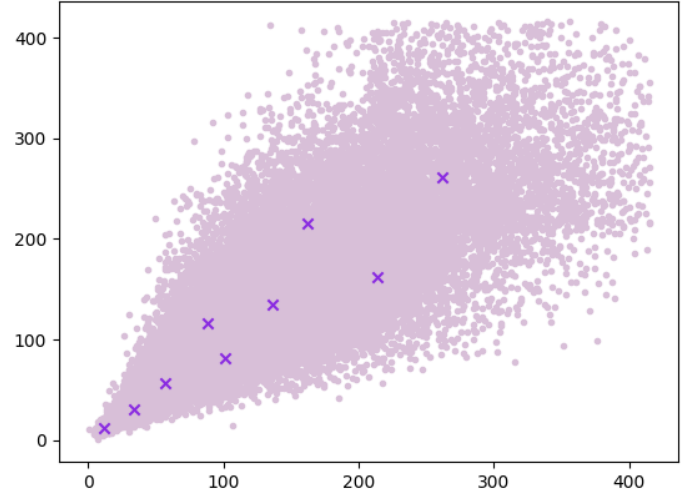
Figure 5. Width and height distribution of the built thyroid cytological dataset for ROI detection. (Horizontal coordinates indicate the width, and vertical coordinates indicate the height).